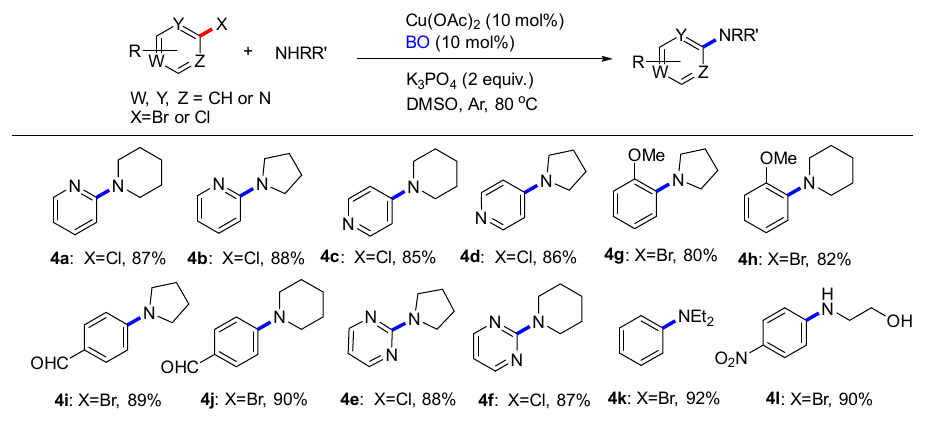
Table 3. C-N Coupling reactions of substituted aryl compounds with amines a,b